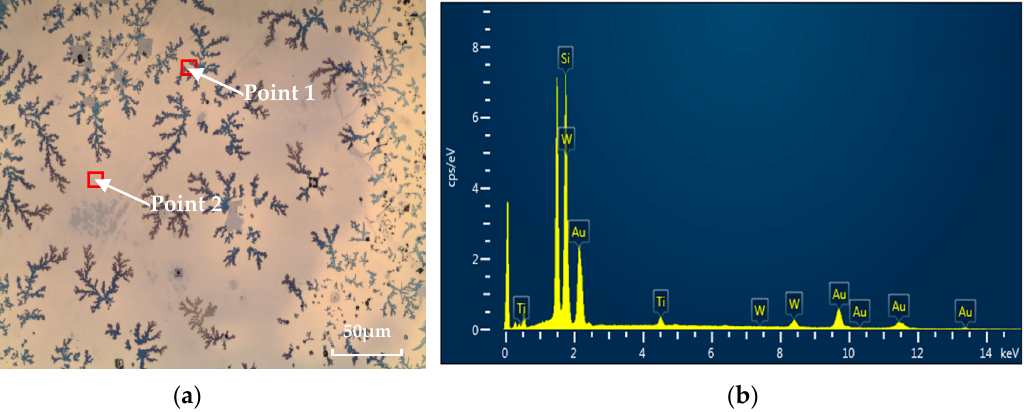
Figure 3. Failed bonding with high heating/cooling rate. ( a ) Separated surface of glass substrates after the blade test; ( b ) component analysis at Point 1.